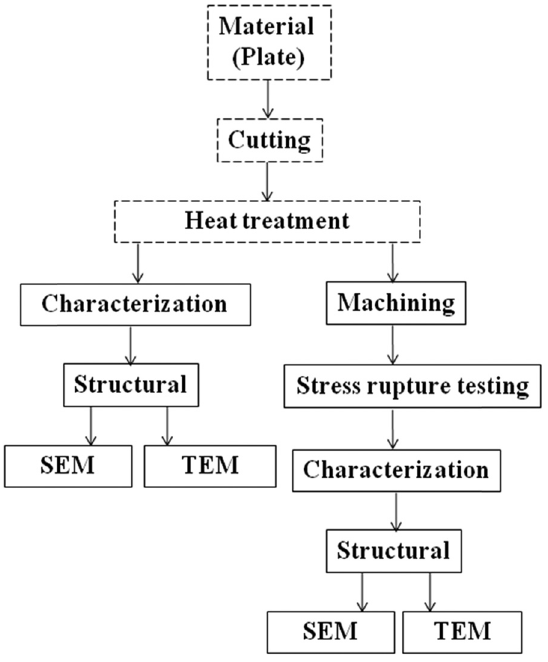
Figure 1: Flowchart of experimentation.